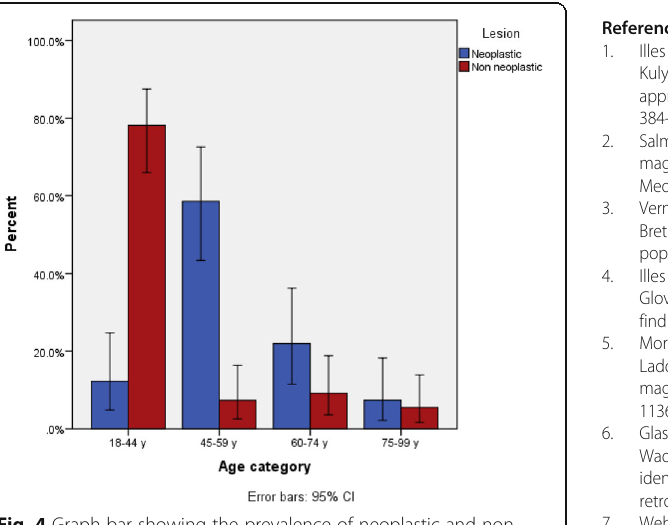
Fig. 4 Graph bar showing the prevalence of neoplastic and non- neoplastic incidental findings in different age groups (with 95% confidence